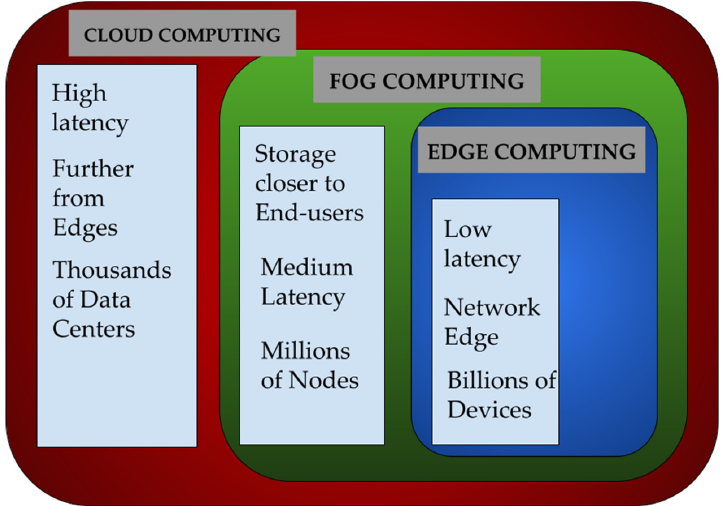
Figure 6. Hierarchical architecture and structural relationship between Cloud, Fog, and Edge com ‐ puting.